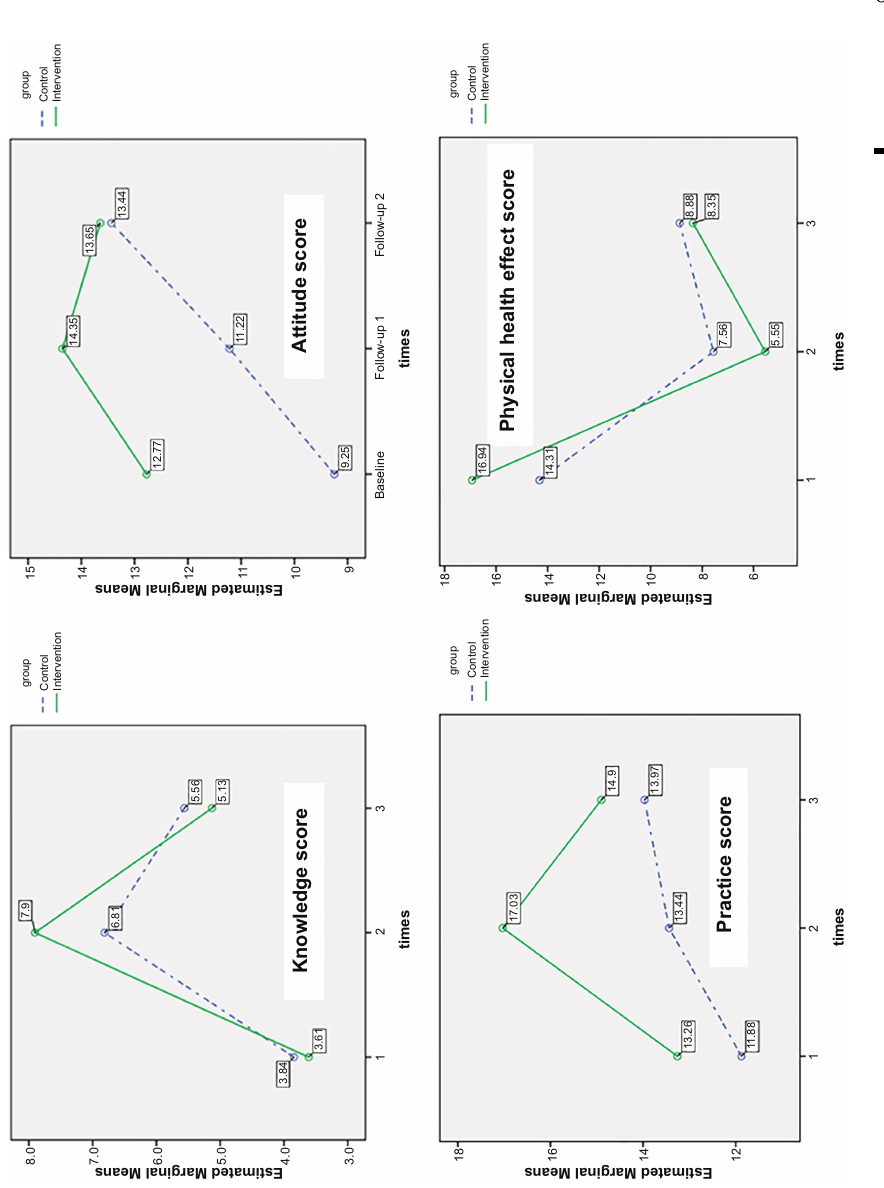
Figure 3. Change over times of knowledge, attitude, practice and physical health effect scores between intervention and control groups at baseline, follow-up 1 and follow-up